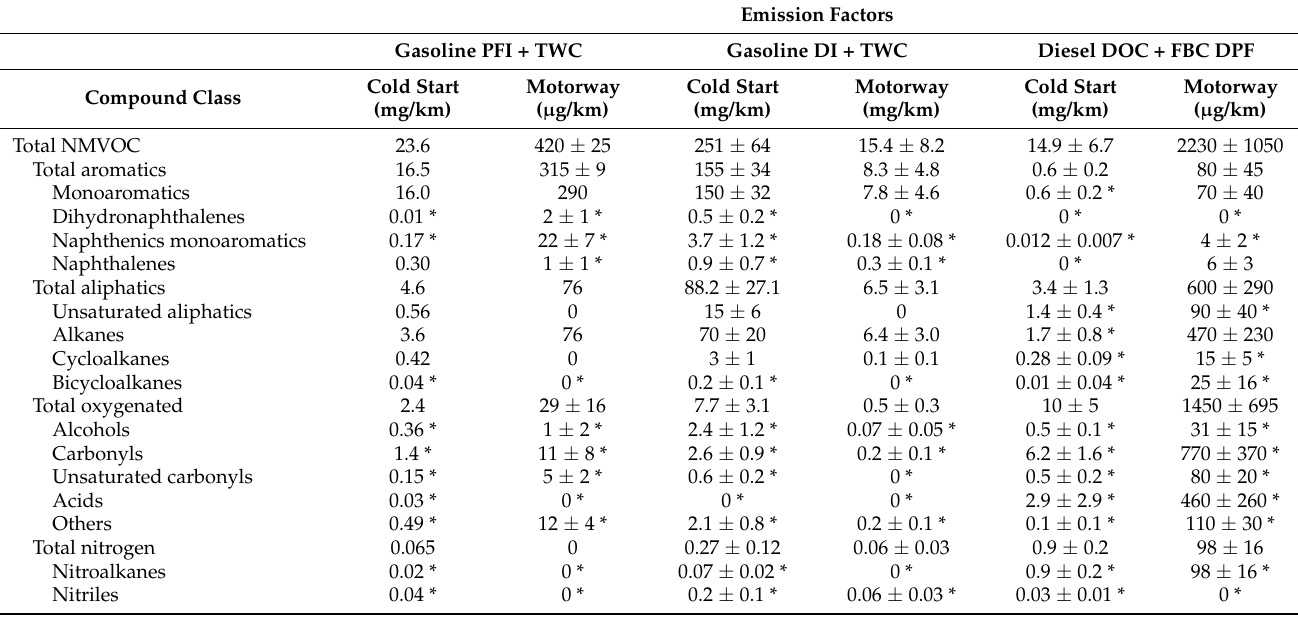
Table 2. Synthetic overview of the total NMVOC EFs and detailed chemical family EFs for the three Euro 5 vehicles during cold urban and motorway cycles. * EFs annotated with an asterisk are calculated from PTR-ToF-MS data, while other EFs are calculated from ATD-GC-MS